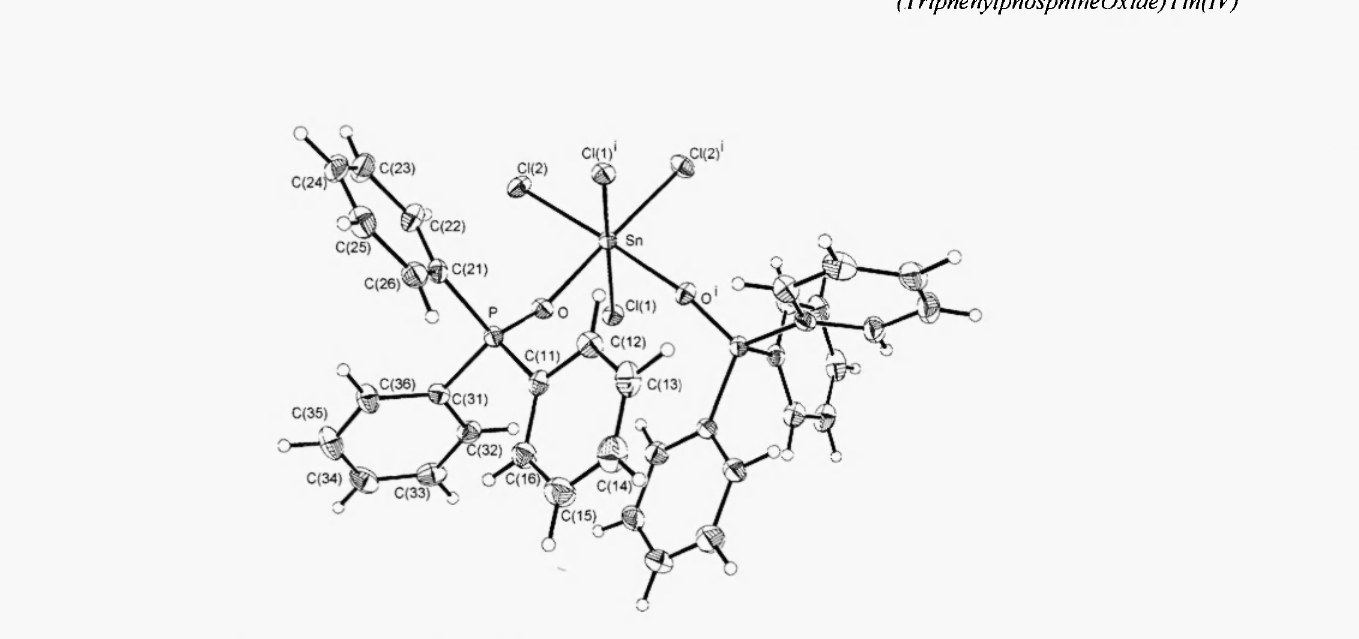
Figure 1. ORTEP drawing of [SnCl 4 (OPPh 3 ) 2 ] (1) showing the atom numbering scheme. Atoms related by the C 2 axis of symmetry are denoted by i. Selected bond lengths (A) and angles (°): Sn-0 2.086(2), Sn-Cl(l) 2.385(1), Sn-Cl(2) 2.395( 1), P -0 1.505(2), O-Sn-O 1 87.02(13), 0-Sn-CI(I)' 87.43(6). 0-Sn-C!( 1) 85.70(7), Cl( 1 )-Sn-Cl( 1) 170.53(4),0-Sn-Cl(2)' 177.38(7), 0'-Sn-Cl(2)' 90.65(7)CI(1)'-Sn-Cl(2) 95.40(3), Cl(l)-Sn-CI(2) 91.20(3), Cl(2)'-Sn-Cl(2) 91.70(5). Symmetry transformations used to generate equivalent atoms: (i) -x. y,-z +